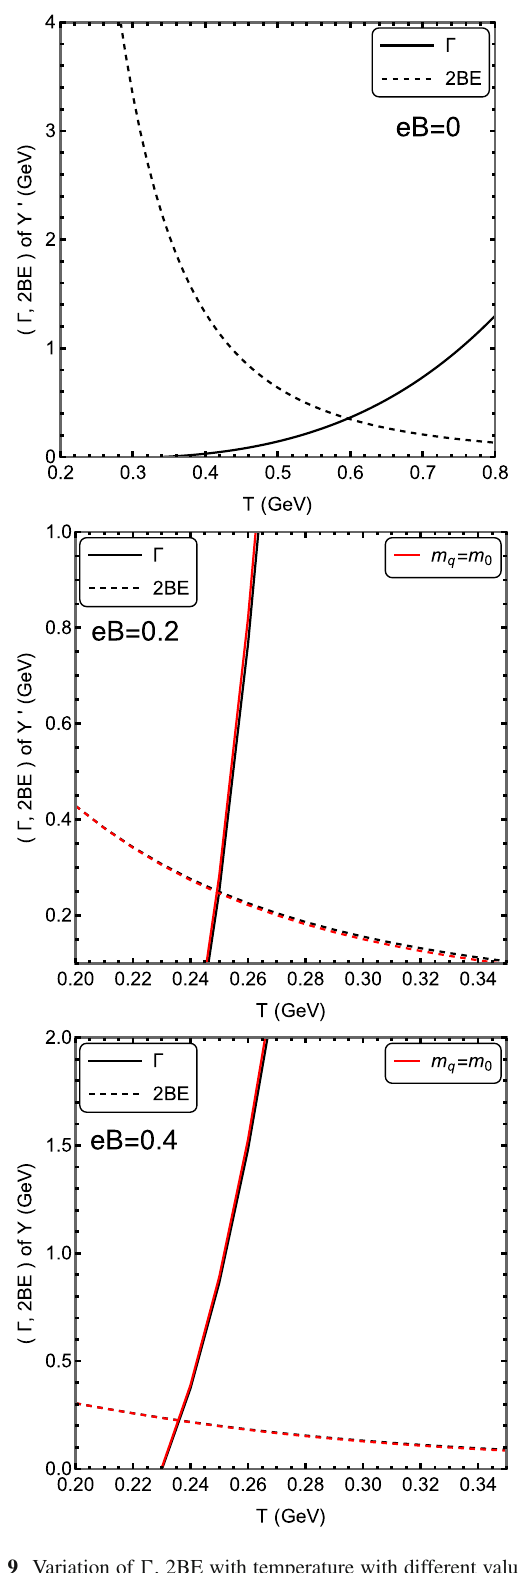
Fig. 9 Variation of (cid:15) , 2BE with temperature with different values of magnetic field (eB) for ϒ